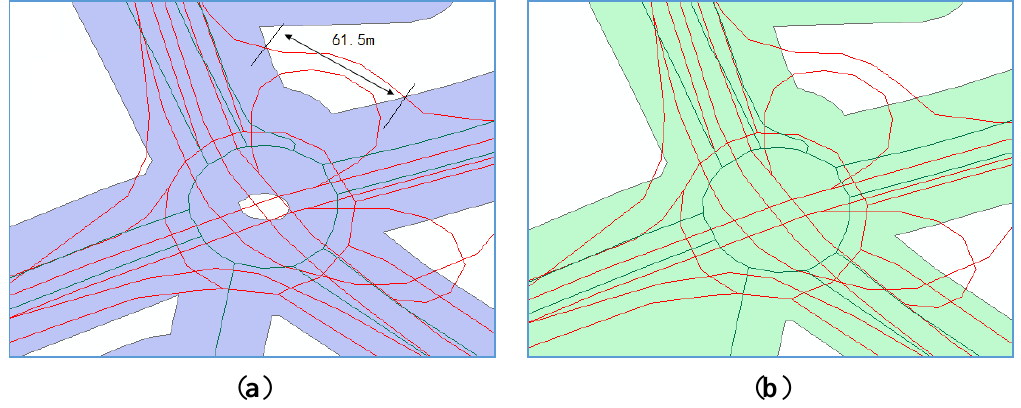
Figure 2. Buffers ( a ) (in blue) at a roundabout and their aggregation ( b ) (in green) to fill the hole at the intersect analysis. The OSM roads are in red and reference roads are in